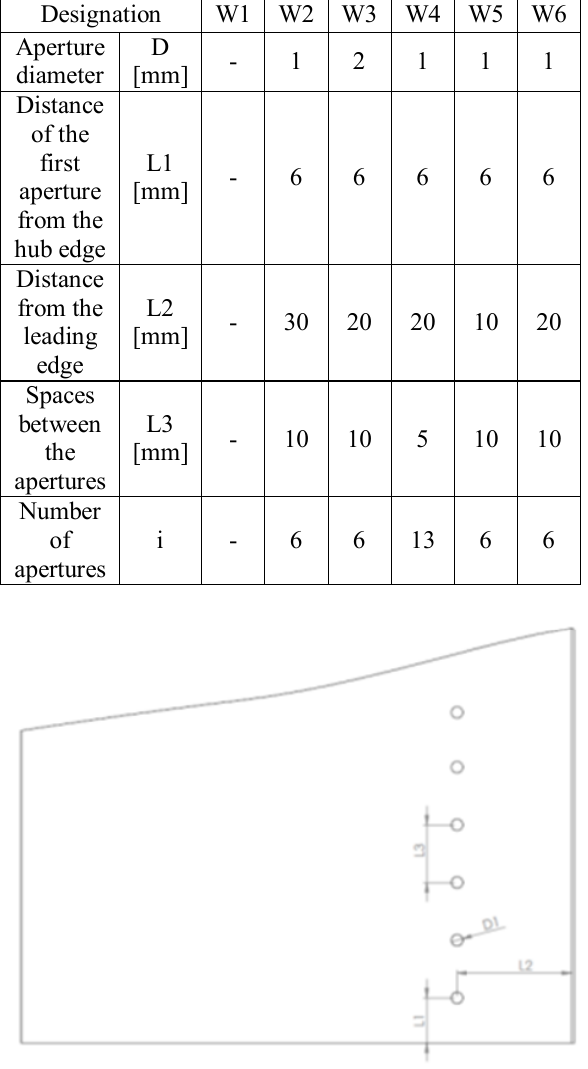
Fig. 2. Blade geometry with the designations The parameters observed during the numerical computations were the total increase of pressure and internal efficiency. Due to small differences between these variables, Figures 3 and 4 present their relative values defined as the differences between the slot configuration being analysed (W2-W6) and the reference case (W1). The below graphs only include results for flows from 0.43 m 3 /s to 0.77 m 3